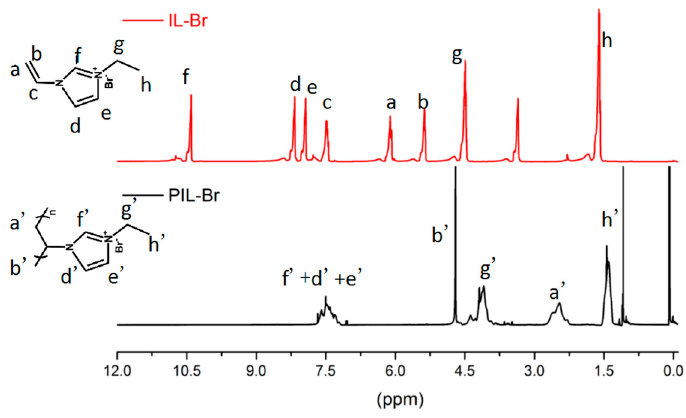
Figure 2. 600-MHz 1 H NMR spectra for PIL-Br and IL-Br.